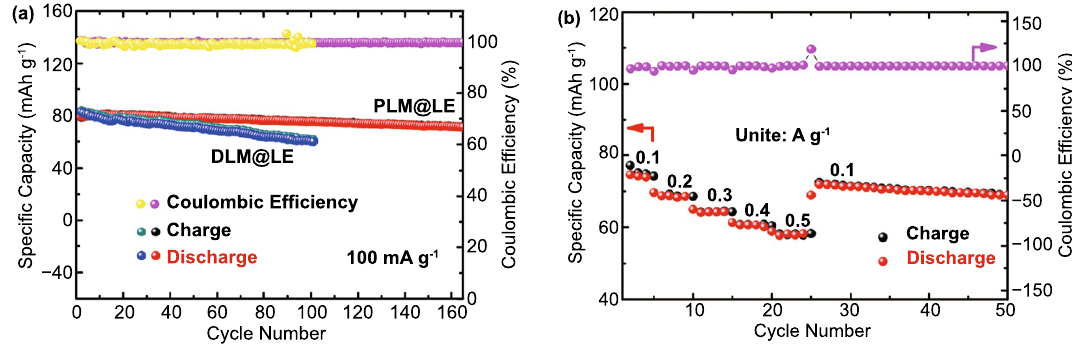
Fig. 6 a Cycling performance of Na 0.44 MnO 2 //PLM@LE//Na and Na 0.44 MnO 2 //DLM@LE//Na solid batteries at 100 mA g −1 . b Rate perfor- mance of Na 0.44 MnO 2